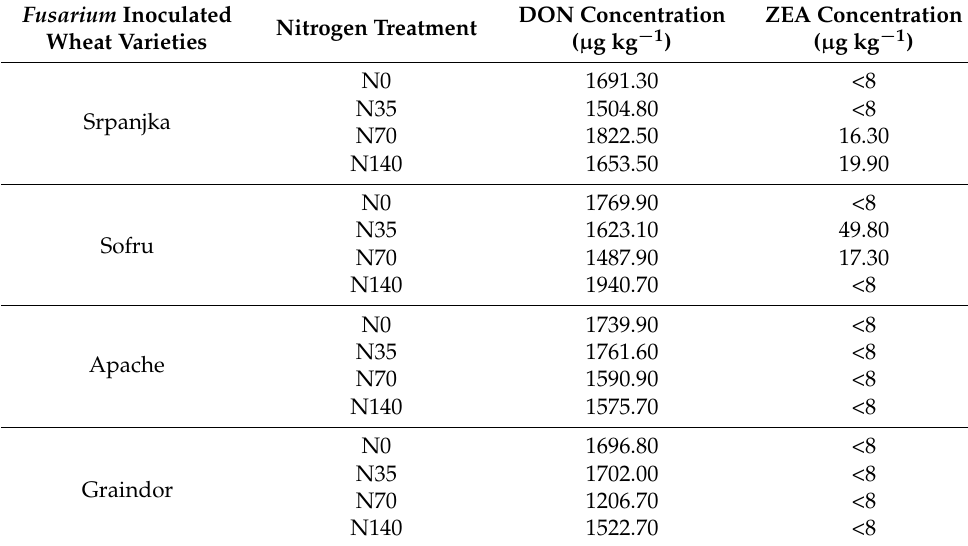
Table 2. The concentrations of mycotoxins deoxynivalenol (DON) and zearalenone (ZEA) in the grains of inoculated wheat varieties in the growing seasons